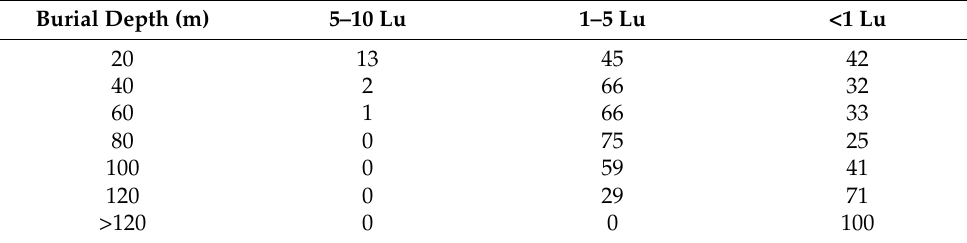
Table 2. Percentage of Lu values for different burial depths